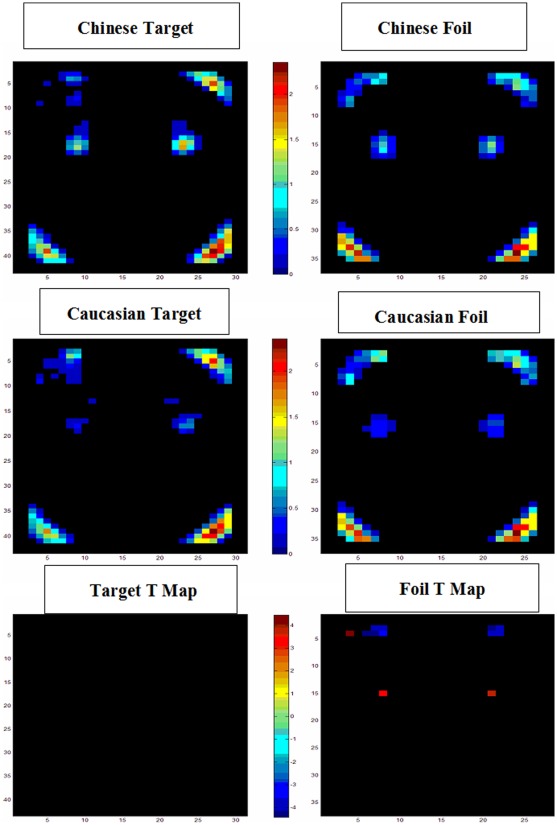
Mean saliency maps for the Chinese target and foil faces, Caucasian target and foil faces, and the significant difference T-maps (Chinese face saliency – Caucasian face saliency).X and Y axes represent the mean horizontal and vertical coordinates of each pixel of the Chinese or Caucasian faces (as measured in the proportion of the corresponding axis of a face). The colors on the top two temperature bars refers to the mean saliency values of the Chinese or Caucasian faces, with warm colors denoting high saliency and cold colors denoting low saliency. The colors on the bottom temperature bar refer to the T value of the difference in saliency between the Chinese and Caucasian images, with warm color denoting positive T values (Chinese faces more salient than Caucasian faces) and cold colors denoting negative T values (Caucasian faces more salient than Chinese faces). Only significant T values are shown (FDR corrected).